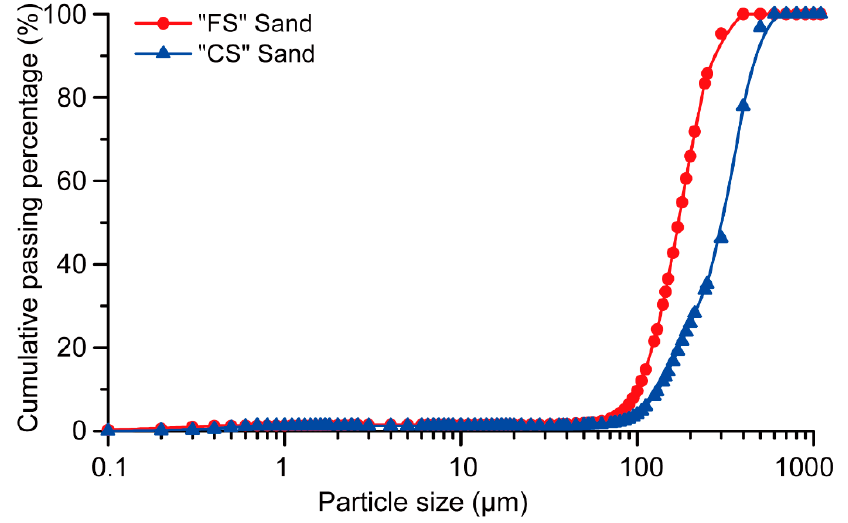
Figure 1. The particle size distribution of silica sands.